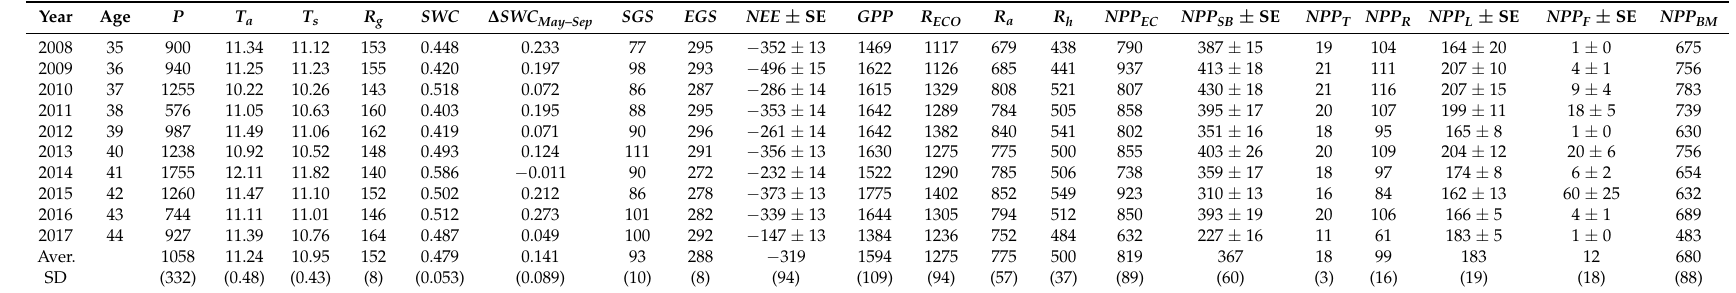
Table 1. Average tree age (years), mean annual precipitation ( P , mm), mean annual air temperature ( T a , ◦ C), mean annual soil temperature ( T s , ◦ C), mean annual global radiation ( R g , W m − 2 ), mean annual soil water content of the 0–30 cm soil layer ( SWC , vol H2O vol − 1 ), difference between mean soil water content in May and in September ( SWC May –SWC Sep , vol H2O vol − 1 ), start of growing season ( SGS , day of year ( DOY )), end of growing season ( EGS , DOY ), annual carbon fluxes (net ecosystem exchange ( NEE) , gross primary productivity ( GPP) , ecosystem reparation ( R ECO ) , from eddy covariance measurements, gC m − 2 year − 1 ), and autotrophic and heterotrophic respiration ( R a and R h , respectively, gC m − 2 year − 1 ). NPP EC and NPP BM are two independent estimates of the annual net primary productivity ( NPP , gC m − 2 year − 1 ). NPP EC is calculated from eddy covariance measurements and from heterotrophic respiration estimates ( R h , see text). NPP BM is calculated from biometric measurements and it is the sum of NPP s of individual tree components: SB (stems and branches), T (twigs), R (coarse roots), L (leaves), F (seeds), SE is the standard error and SD is the standard deviation of the annual average (Aver.) during the period of the study. Note: Values of SD are in brackets in order to